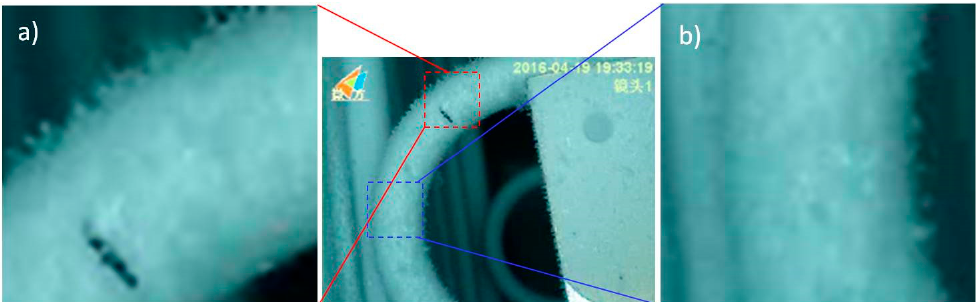
Figure 8. Frost formation process and variation of frost mass after 467 min with different surface conditions: ( a ) normal surfaces; ( b ) PDMS-SiO 2 /PFA hybrid coating surfaces. Note: 微 方 is a brand and 镜 头 1 means camera